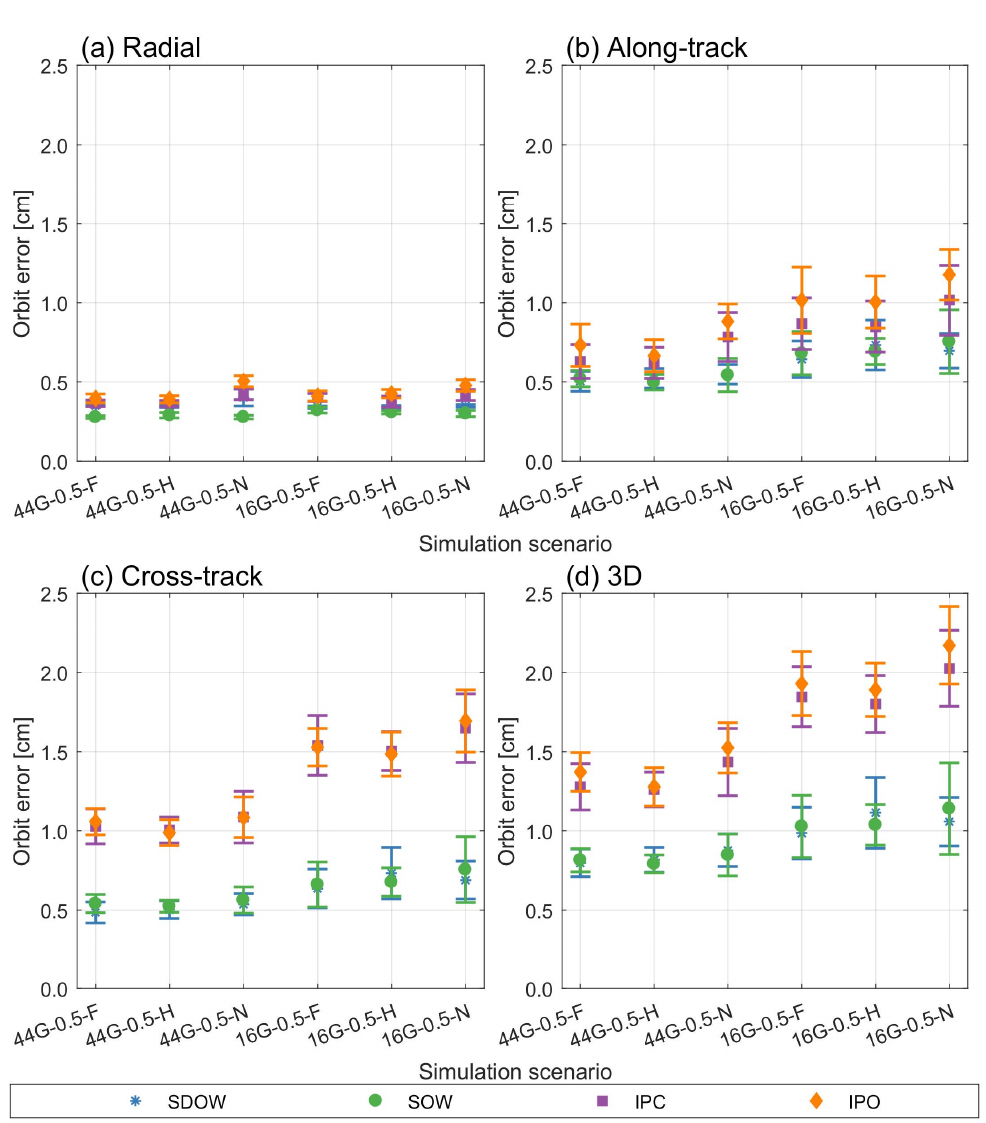
Figure 3. Comparison of the Helmert and Förstner approaches with Nominal and their impact on orbit estimation mean RMS errors for ( a ) radial, ( b ) along-track, ( c ) cross-track components, and ( d ) the total 3D RMS value. The simulation scenario names are given in Table 3.